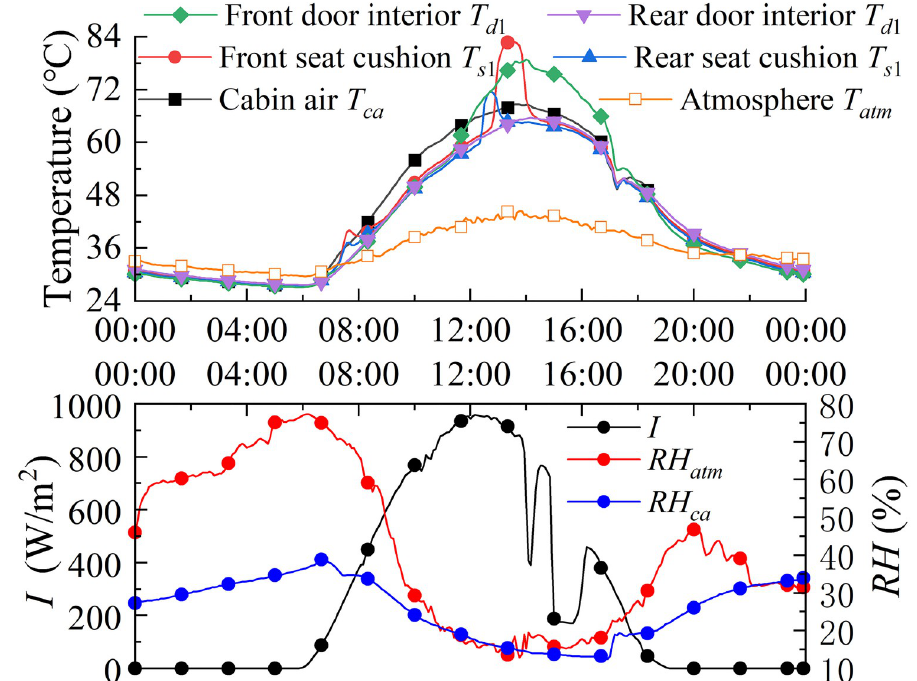
Fig 9. Temperature and humidity distribution on July 15. The car suffered from the worst heat load at noon, with a maximum T ca of